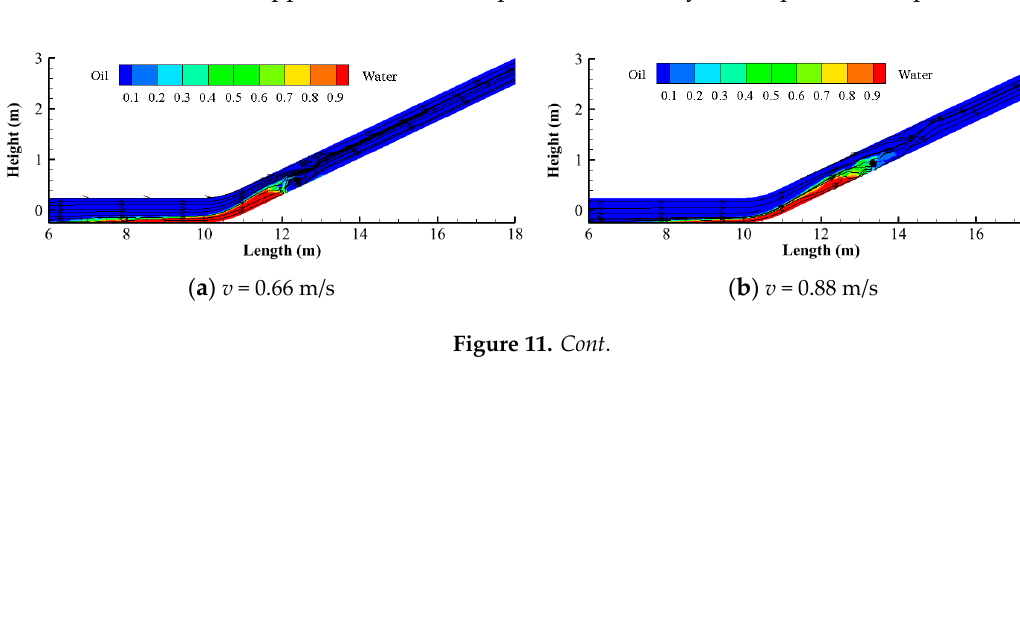
Figure 10. Distribution of oil and water ( α = 10°, t = 11.0 s).